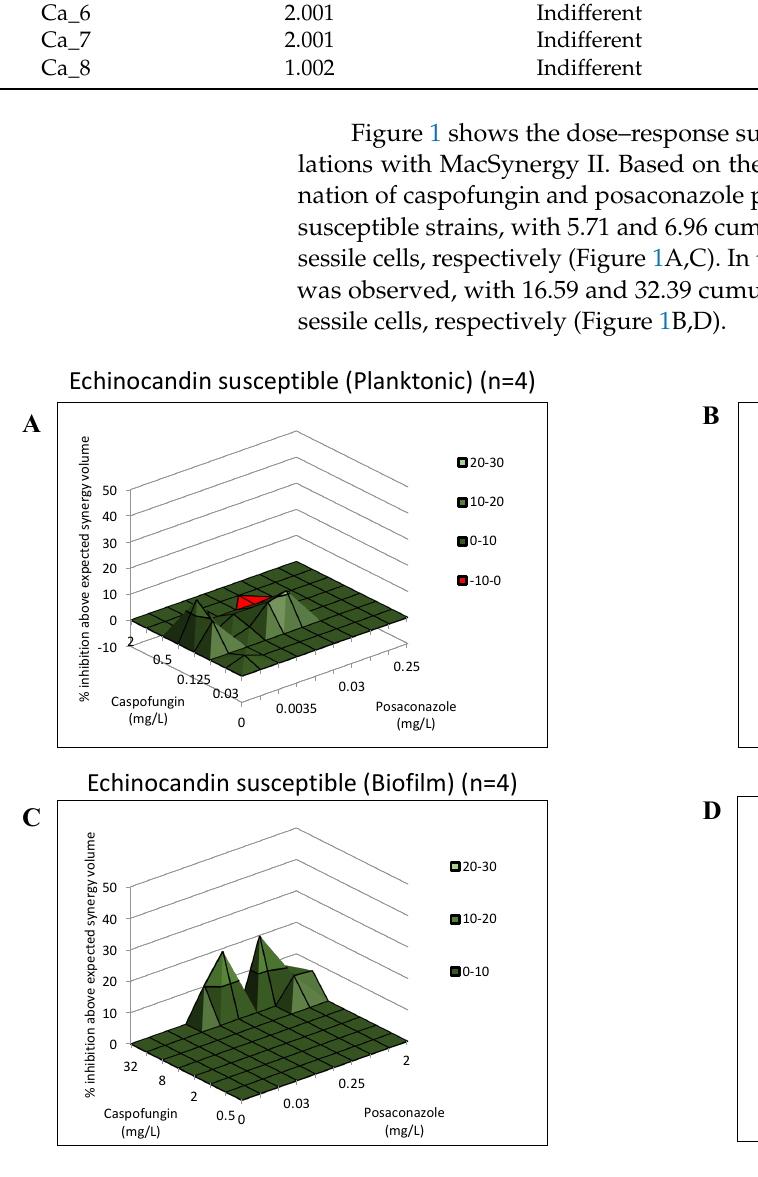
Figure 1. Effect of caspofungin in combination with posaconazole against Candida auris planktonic cells ( A , B ) and biofilms ( C , D ) using MacSynergy II analysis. Additive interactions appear as a horizontal plane at 0% inhibition. The interaction is defined as synergistic if the obtained surface is greater compared to the predicted additive surface. The volumes are calculated at the 95% confidence interval. The figures represent the cumulative synergy volume in case of four-four FKS wild-type ( A , C ) and mutant ( B , D ) isolates for planktonic cells and biofilms,